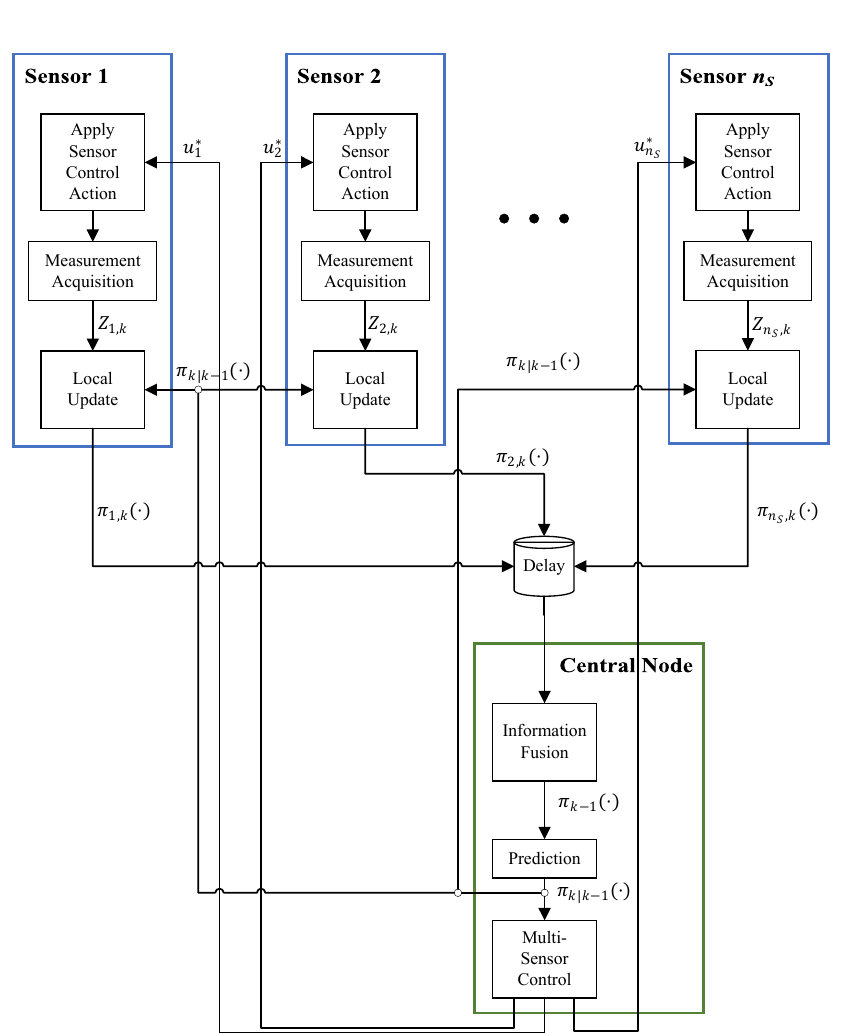
Figure 4. The general block diagram of a multi-sensor control system within a centralized sensor